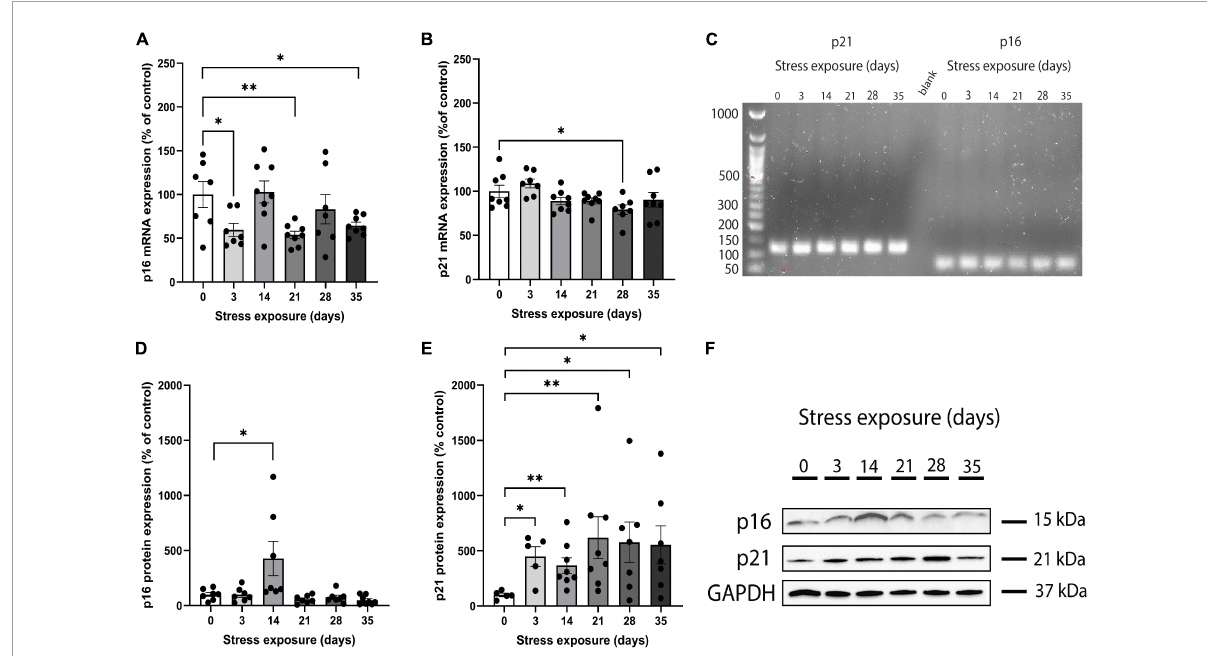
FIGURE1 Chronic restraint stress (CRS) induces abnormal mRNA and protein expression of p16 INK4a and p21 Waf1 / Cip1 in mice. (A) The p16 INK4a mRNA expression levels were lower in mice submitted to CRS than the control group after 3, 21, and 35 days of stress exposure. (B) The p21 Waf1 / Cip1 mRNA expression levels were lower in mice submitted to CRS compared to the control group after 28 days of stress exposure. (C) Full length electrophoresis gel image showing single amplicon bands after RT-qPCR for p21 and p16 INK4a genes expressed in PFC of mice submitted to CRS (0–35 days of exposure). (D) The p16 INK4a protein expression levels were higher in mice submitted to CRS compared to the control group after 14 days of stress exposure. (E) The p21 Waf1 / Cip1 protein expression levels were higher in mice submitted to CRS compared to the control group after 3, 14, 21, 28, and 35 days of stress exposure. (F) Western blot analysis showing the protein expression levels of p16 INK4a , p21, and GAPDH in PFC of mice submitted to CRS (0–35 days of exposure). Data showed were obtained in both male and female, and were presented as mean ± SEM. ∗ p < 0.05, ∗∗ p <